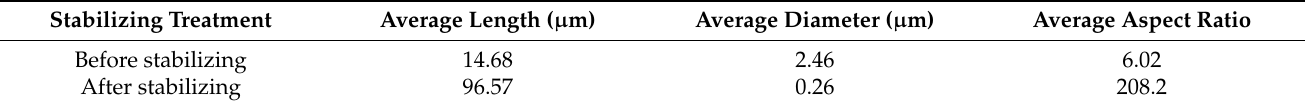
Figure 12. XRD patterns of the samples before and after stabilizing. Table 4. The size of the CSHW before and after stabilizing.